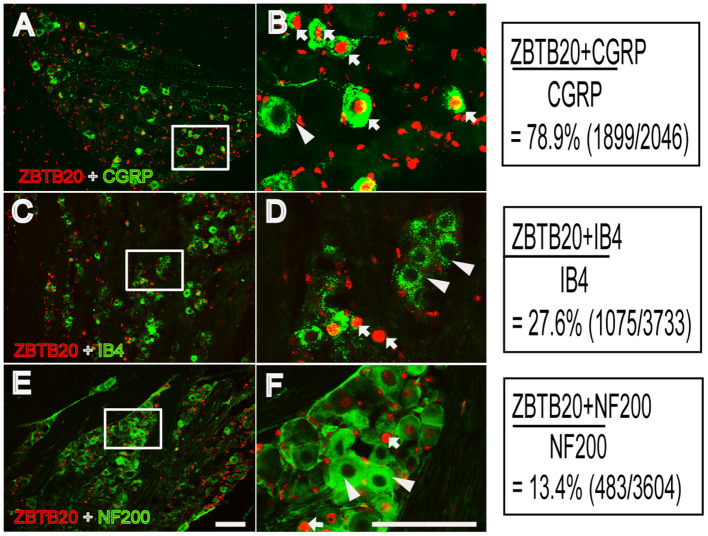
Colocalization of ZBTB20 with CGRP, IB4, and NF200 in the trigeminal ganglia. (A,B) Colocalization of ZBTB20 with CGPR. (C,D) Colocalization of ZBTB20 with IB4. (E,F) Colocalization of ZBTB20 with NF200. Figures B,D,F are high magnifications of the boxes in Figures A,C,E. The arrowhead indicates the colocalization of ZBTB20 with CGRP, IB4, and NF200 in Figures B,D,F. The arrow indicates the expression of CGRP, IB4, and NF200 without colocalization with ZBTB20 in Figures B,D,F. N = 3; bar =50 μm.